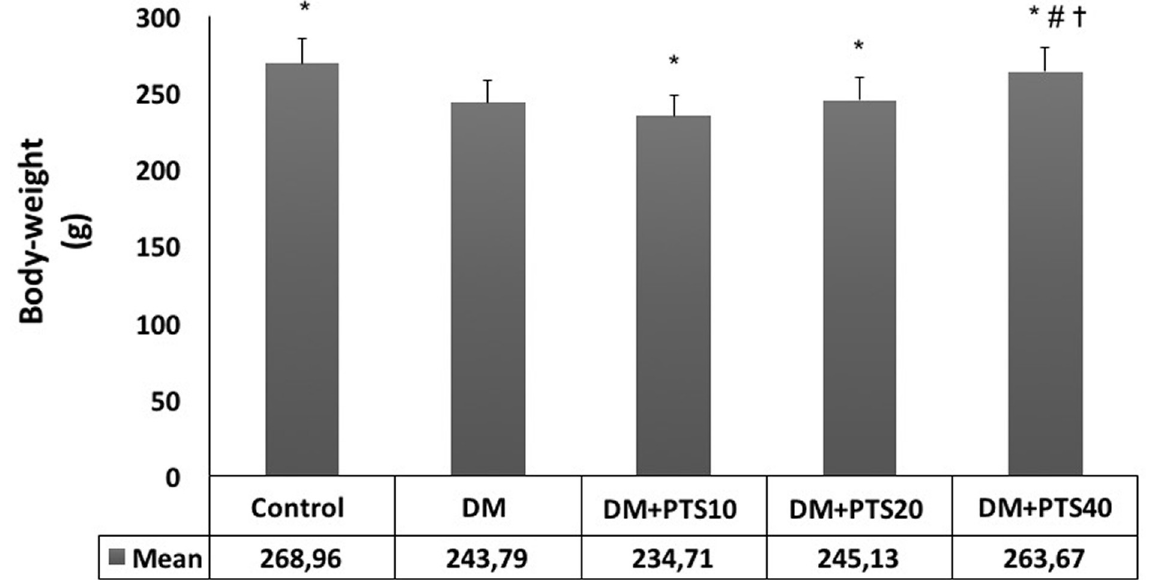
Fig 6. Body-weight (g) change of the rat groups after STZ-application to end of the experimental period. � Significantly different from DM (P < 0.001 for all), # different from all treatment rat groups (P < 0.001 for all), and ✝ similar to Control (P = 0.822). https://doi.org/10.1371/journal.pone.0228429.g006 The serum insulin levels were significantly lower in the untreated diabetic rats compared to the healthy Control group and all the PTS treatment groups (P < 0.001 for all). The diabetic rats that received PTS had increased insulin levels after 10, 20, and 40 mg/kg/day of PTS com- pared to the untreated diabetic rats (P < 0.001 for all). However, 20 and 40 mg/kg/day of PTS treatment were more effective in increasing serum insulin levels than the 10 mg/kg/day PTS dose (P < 0.001 for all) (Fig 7).